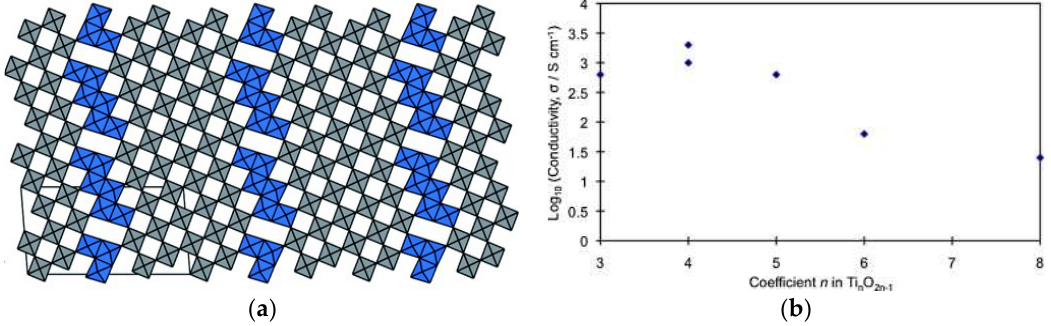
Figure 13. ( a ) Magneli shear planes providing access for electrons transport. Reproduced from [130], Copyright 2014, Royal Society of Chemistry. ( b ) Relative electrical conductivities of Magneli phase titanium sub-oxides. Reproduced from [92], Copyright 2010, Elsevier.